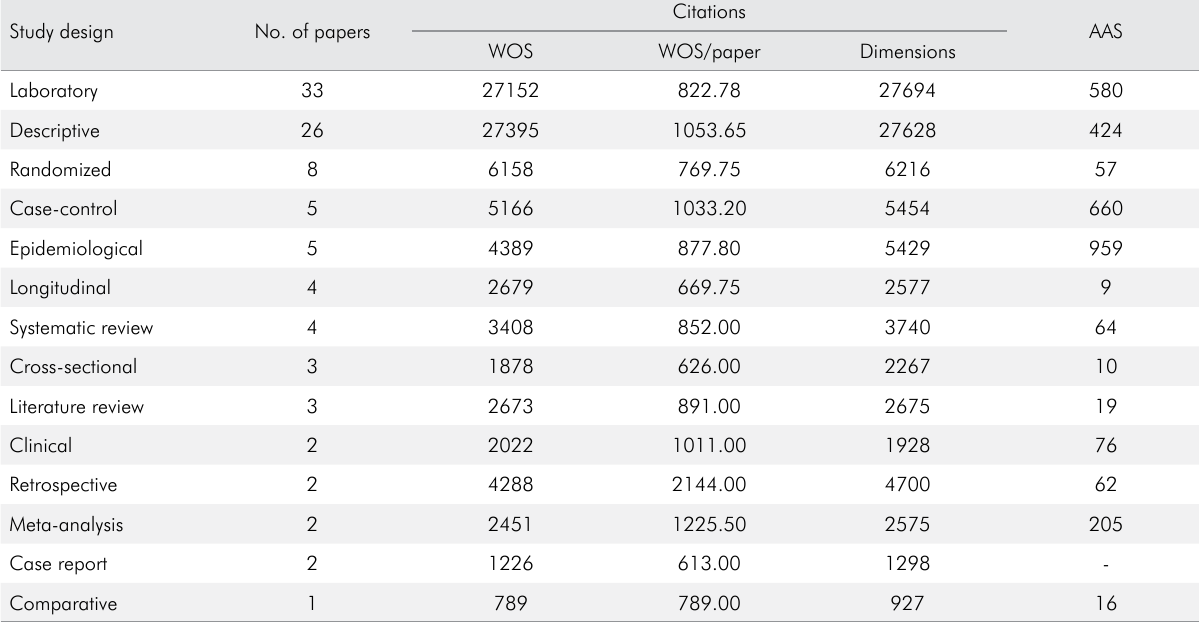
Table 5. Study designs used in the 100-top cited papers in pathology and oral